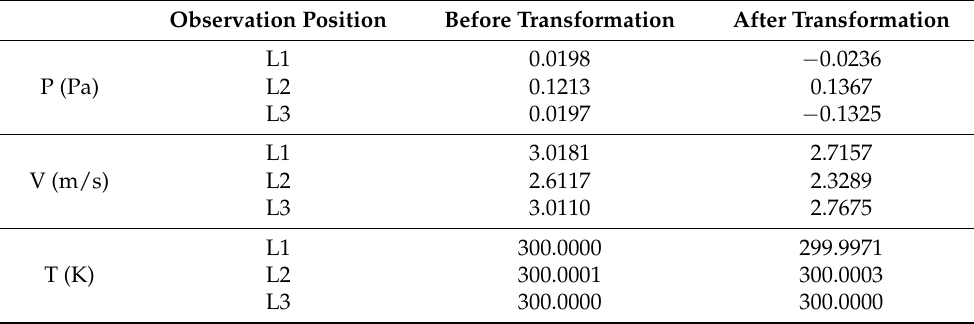
Table 5. Comparison of observation points before and after planning and transformation. Observation Position Before Transformation After Transformation